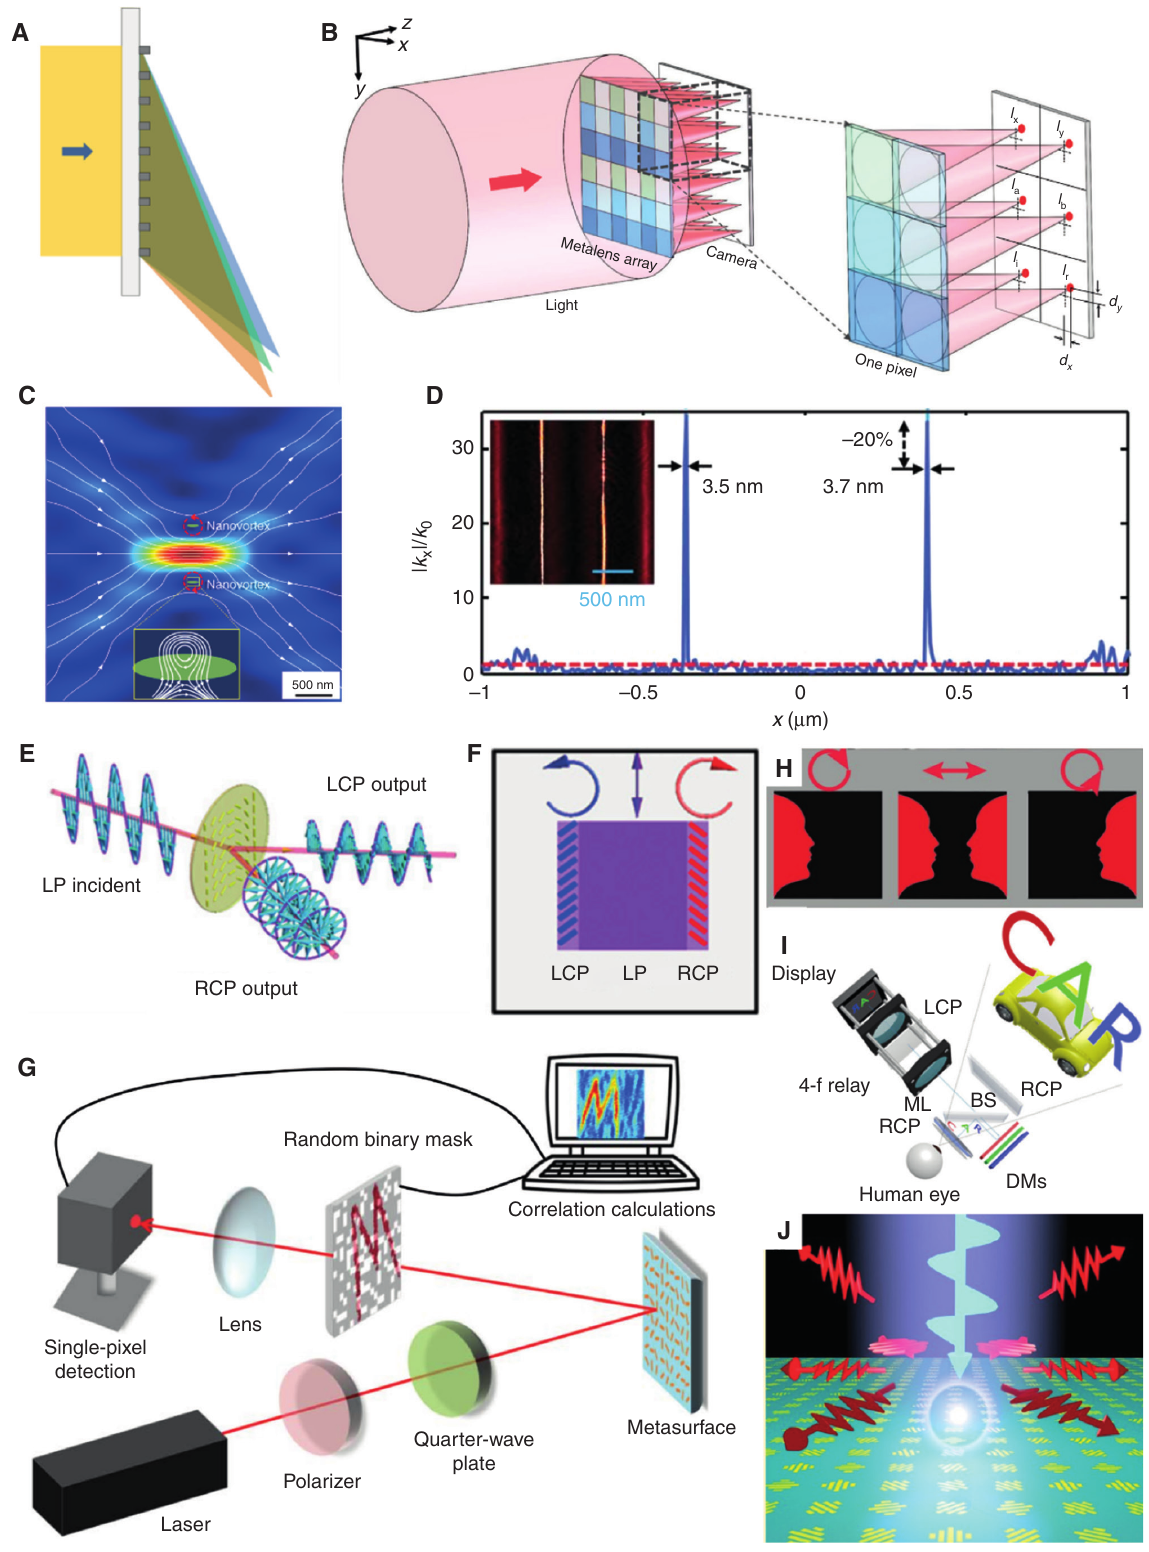
Figure 16: Application examples of GEMS. (A) Spectral measurement [117]. (B) Polarization state measurement [118]. (C) Generation of superoscillation [119]. (D) High-precision displacement measurement [120]. (E and F) Image edge inspection [121]. (G) Single-pixel GI [122]. (H) Optical illusion [123]. (I) AR [124]. (J) Polarization-independent beam scattering [125]. Reprint permission obtained from